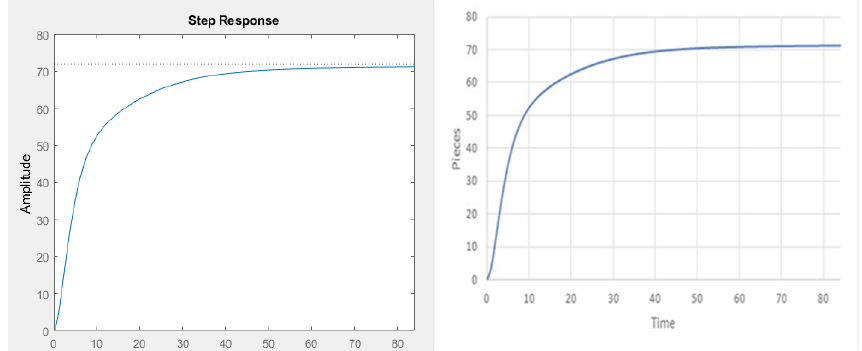
Figure 26. Output at a step input with amplitude 72 and with the Stella software.